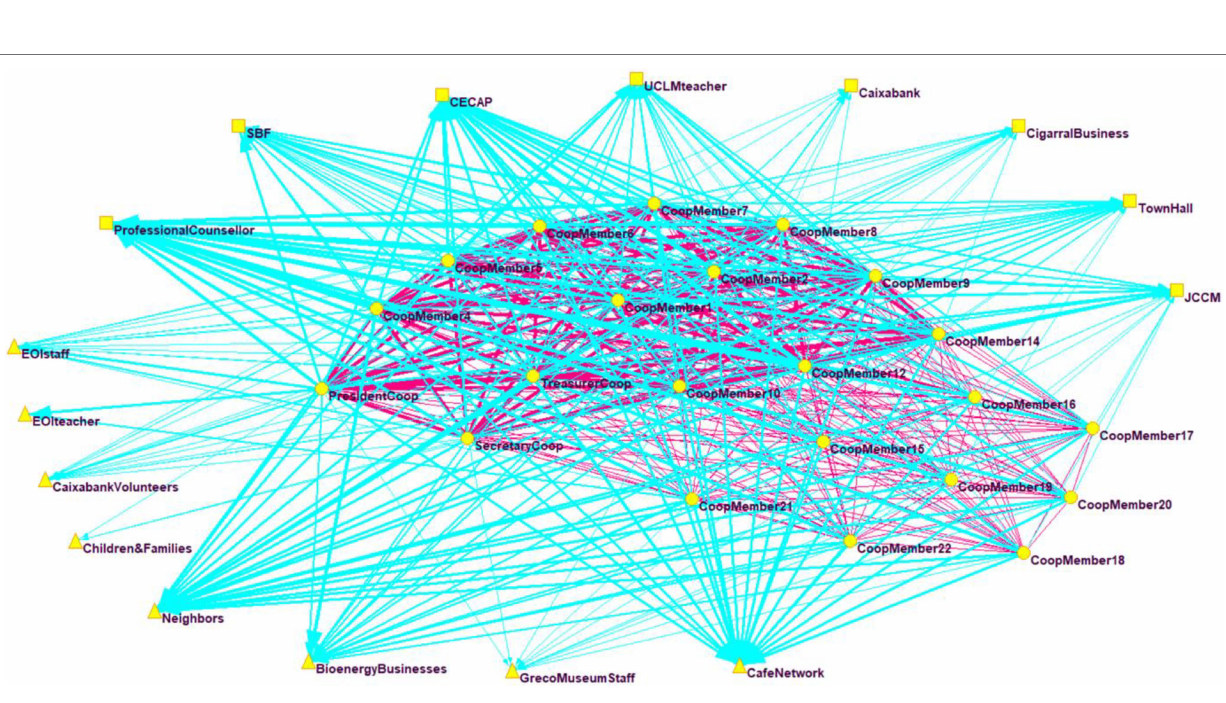
FIGURE 2 | Network of entrepreneurs after company creation. The members/workers of the cooperative (internal stakeholders) are represented by circles, while external stakeholders (organizations that maintained some kind of contact prior to the creation of the company) are represented by squares and triangles (new contacts). The relations between the members of the company are drawn in fuschia and the external ones in